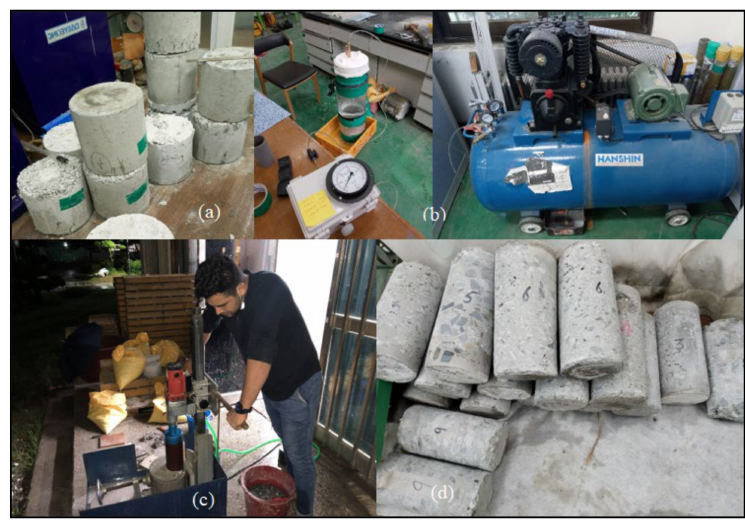
Figure 11. ( a ) Samples for the mass strength, ( b ) test for permeability, ( c ) use of rotary drill to extract cylinders, and ( d ) extracted cylinders having 100 mm diameter and 200 mm length.